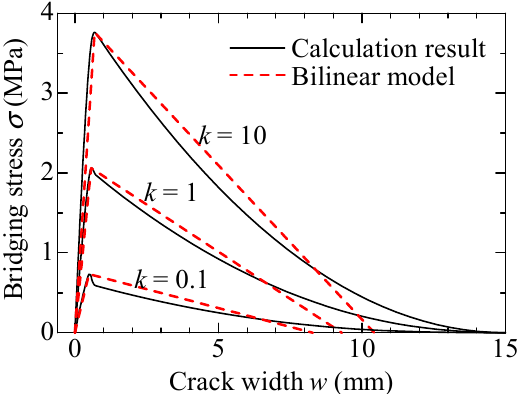
Figure 6. Comparison between the calculated bridging law and model.